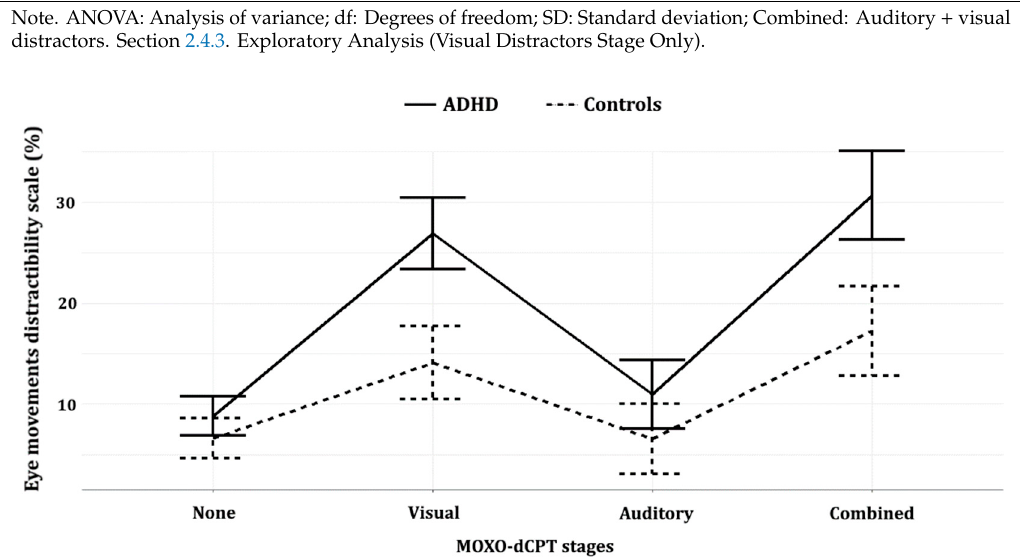
Figure 3. Eye movement distractibility line plot, of the four distractor-type stages. Error bars represent standard error (SE) of the repeated-measures ANOVA analysis (see Table 4).